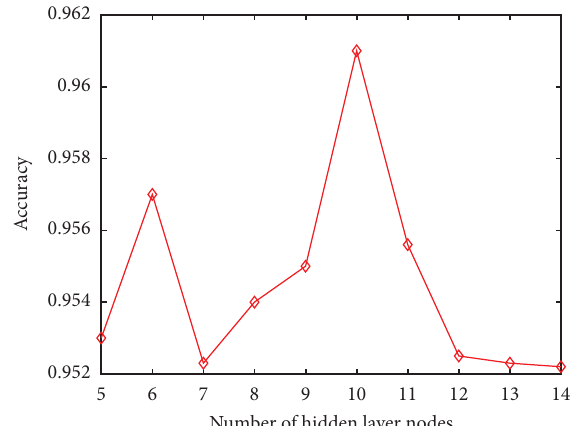
Figure 3: Te efect of a diferent number of hidden layer nodes on model training.